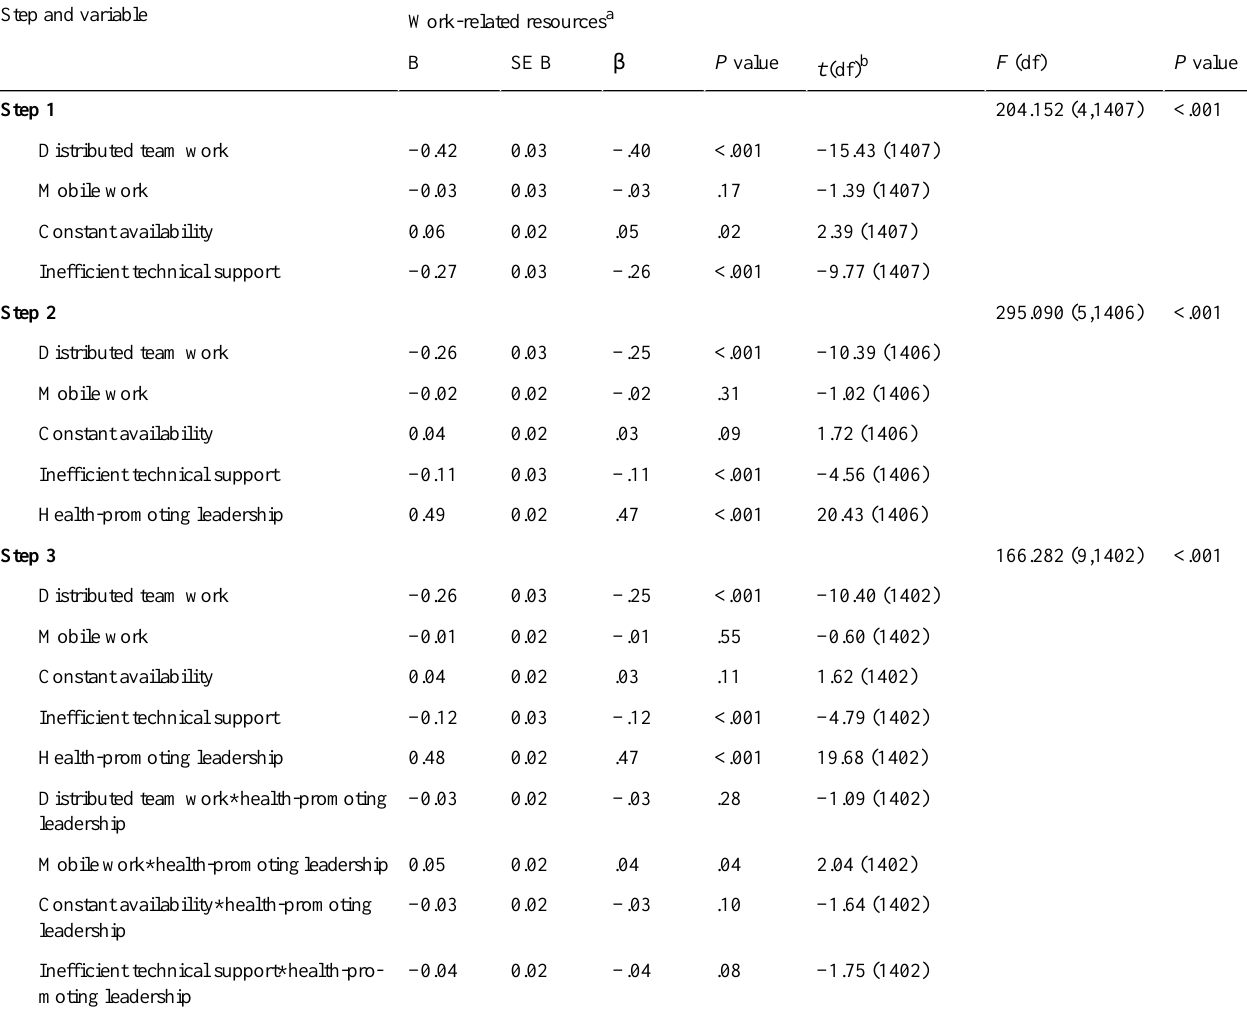
Table 5. Results of hierarchical multiple regression analyses for the criterion work-related resources (R2=51.3%).